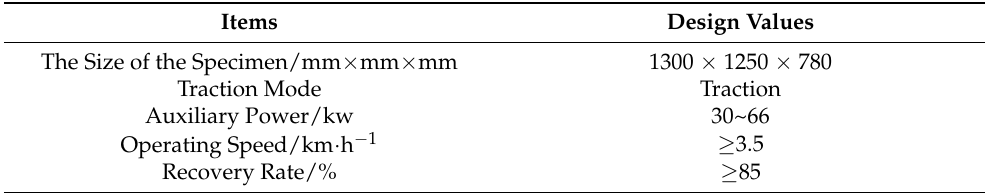
Table 2. Major Technical Parameters.